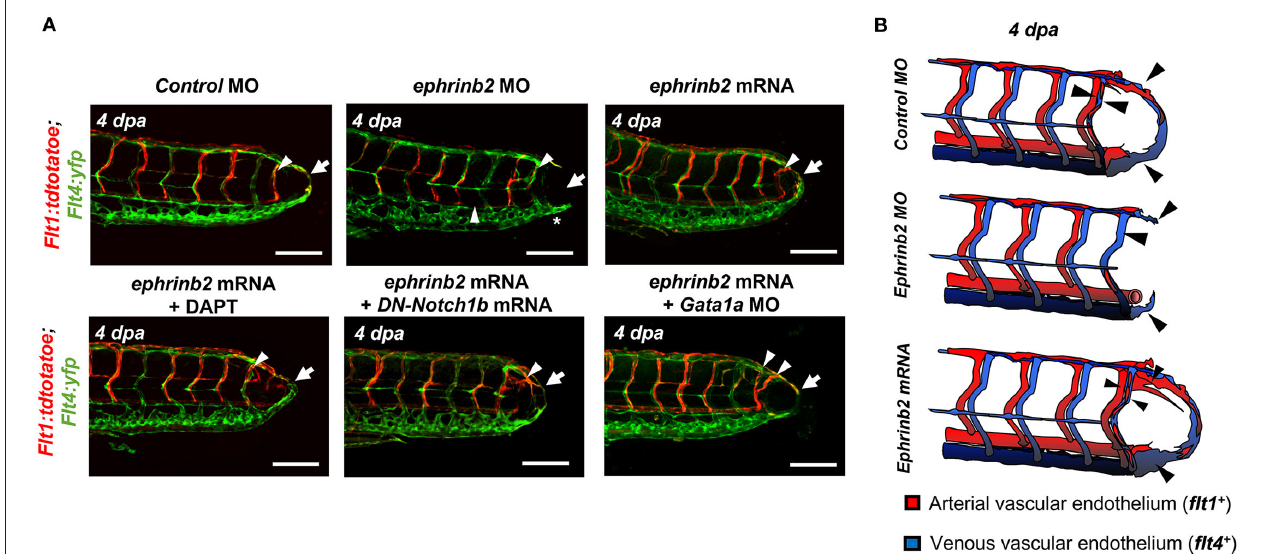
FIGURE 6 | WSS-responsive Notch-ephrinb2 pathway regulates arterial network formation. (A) Injection of ephrinb2 MO (0.5-1mM) diminished flt1 + in the amputated site (white arrowheads) to attenuate loop formation at 4 dpa (white arrow). Transient overexpression of ephrinb2 mRNA promoted flt1 + network formation in the amputated site (white arrowheads) and restored DAPT and DN- Notch1b mRNA-impaired flt1 + regeneration (white arrow) ( n = 20 per group). Scale bar: 20 µ m. (B) Schematic representations of ephrinb2-dependent flt1 + and flt14 + regeneration. Black arrowheads depict regenerated flt1 + (Red) and flt4 + (Blue) in response to differential ephrinb2